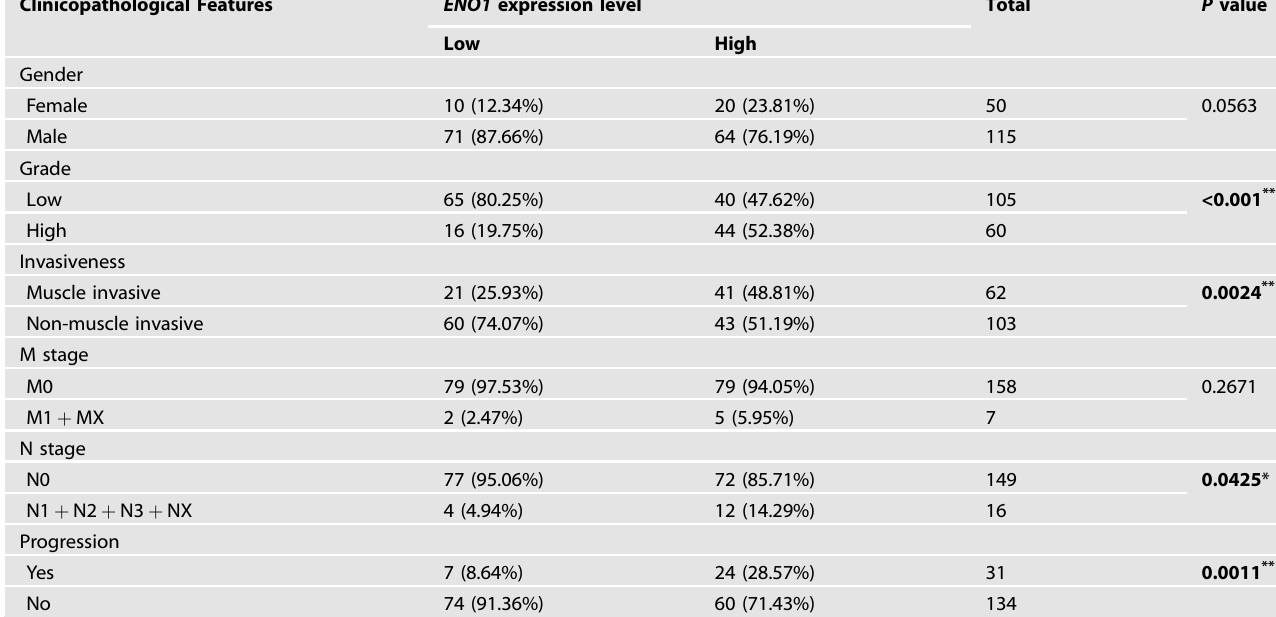
Table 1. Clinicopathological statistics of BLCA patients from GSE13507 based on ENO1 expression level. Clinicopathological